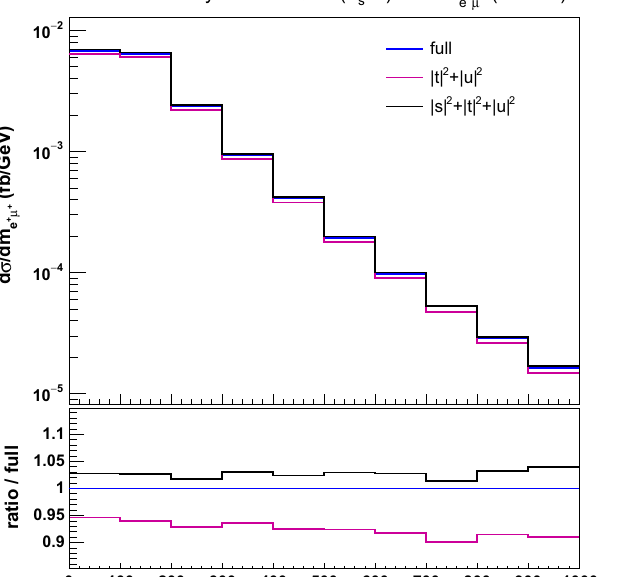
plots present all predictions normalised to MoCaNLO + Recola which is one of the programs that provide the full prediction. In addition to the cuts of Sect. 3.3, the VBS cuts take the values m jj > 200GeV and | Δ y | > 2 jj